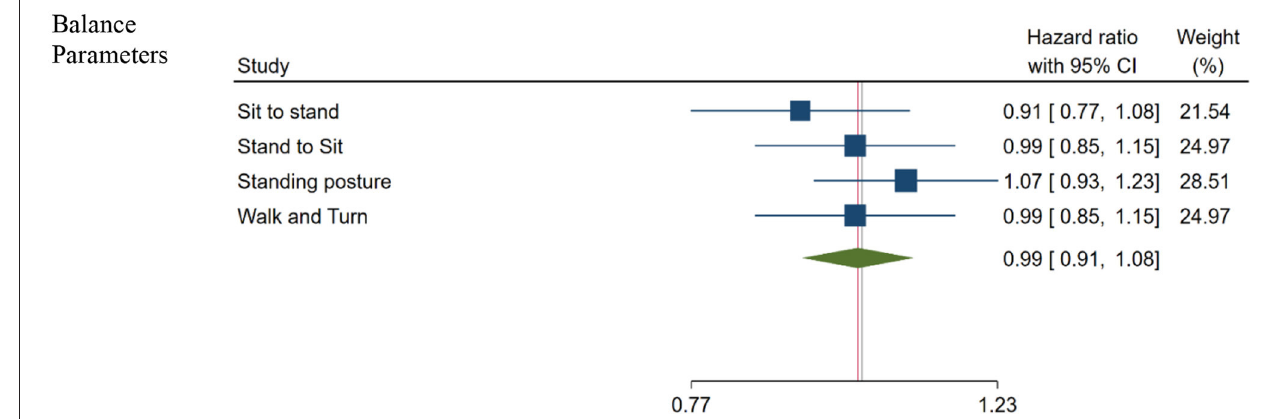
FIGURE 3 | Forest plots: predictors of